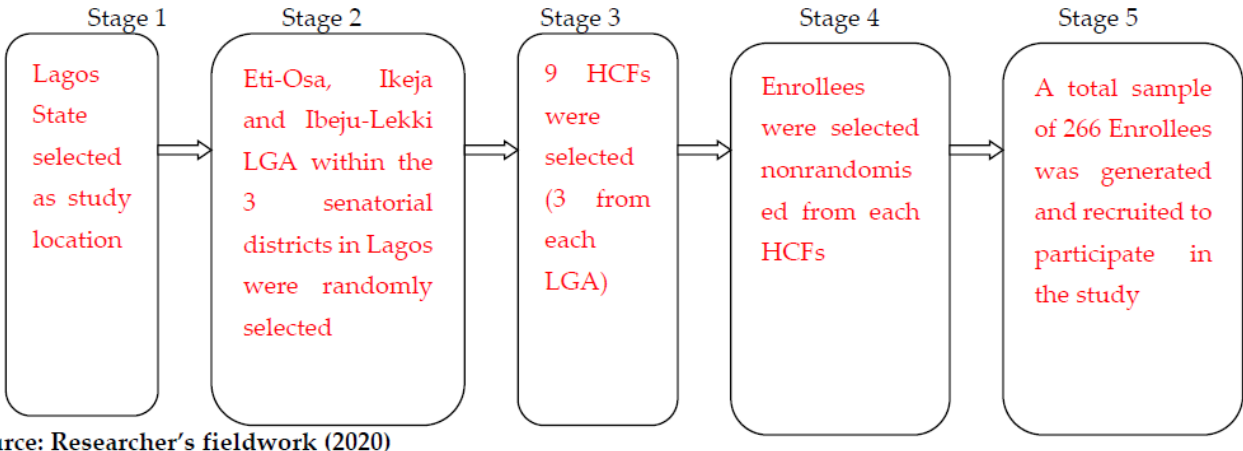
Figure 1. Multistage sampling approach for study area and study participants.